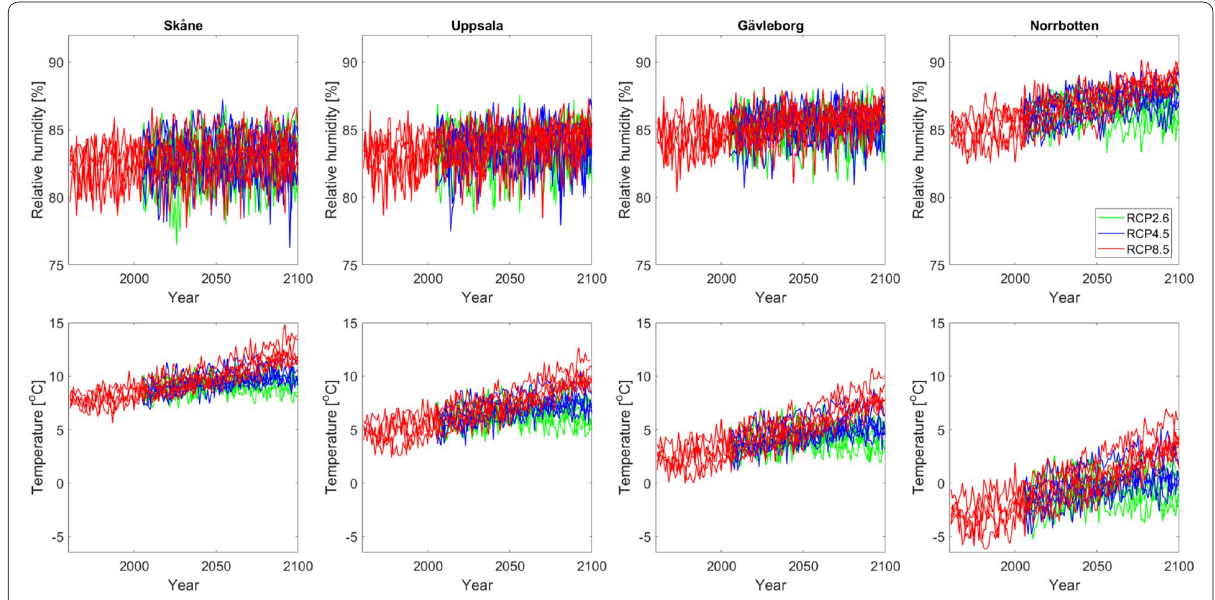
Fig. 1 Projections of the annual average values of relative humidity and temperature for Skåne, Uppsala, Gävleborg, and Norrbotten; counties are ordered from south (left) to north (right); multiple lines for each scenario represent different climate projections based on the five used GCMs (EC-EARTH, MIROC5, HadGEM2-ES, MPI-ESM-LR, and